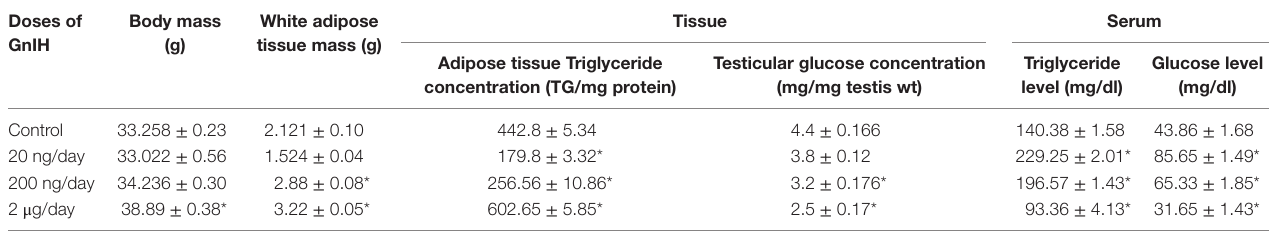
TaBle 3 | effect of gnih on body mass, WaT mass, adipose tissue Tg, testicular glucose, serum Tg, and serum glucose mice ( in vivo ). Doses of gnih